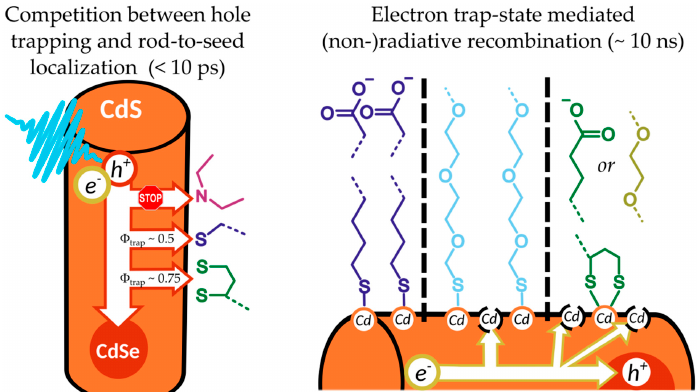
Figure 5. Summary of the effect of different water-soluble ligands on the excited state properties of CdSe@CdS NR. On a sub-10-ps timescale, mono- and ditholates offer hole trapping sites, opening a channel for processes competing with exciton localization to the CdSe core, while PEI prevents any trapping. On a ns-timescale, radiative exciton recombination is impaired by non-radiative processes induced by electron trapping sites. These result from the presence of either the bulky hydrophilic chain (PEG) or the anchoring group (in particular, DHLA). PEI (not shown) allows for a near-unity charge recombination, saturating surface defects very efficiently without inducing additional hole trapping sites. Surface ligands can impede charge carrier localization to the CdSe core. Photoinduced rod-to- seed localization of charge carriers is a fast process in NR, occurring within several picoseconds, and efficient rod-to-seed localization has been found to be a key parameter determining catalytic efficiency in systems building on seeded NR [4]. From excitation wavelength dependent photoluminescence quantum yield measurements, we could infer that trapping of holes on the surface efficiently competes with hole localization in mono- and dithiolate-NR, with trapping efficiencies of circa 0.5 and 0.75, respectively. PEI-coating, on the other hand, passivates the surface and changes the electronic structure of the NR that hole-traps are not accessible anymore, giving access to a rod-to-seed localization efficiency of nearly unity. Comparison of the relative amplitudes of the hole-localization driven electron rod-to-seed localization in transient absorption measurements were in good agreement with this finding. Hole localization in the seed in metal tipped seeded NR was shown to improve excited state lifetime [77], which correlates with improved photon-to-hydrogen conversion efficiencies [4]. In line with this, thiolate-NR showed significantly lower catalytic efficiencies compared to, for instance, PEI-NR [19]. Disorder in the ligand shell can be the source of additional electron trap states. Generally, the MAAs investigated behaved nearly identical compared to their PEG-analogues in terms of photoluminescence quantum yield and charge localization efficiency. However, some distinct changes in the photoluminescence decay, which is an indicator for the radiative recombination of the core-localized exciton on the nanosecond timescale, were recorded. While MUA-NR exhibited a monoexponential decay, it changed to a biexponential emission decay for HS-PEG-NR. This finding was rationalized on the basis that bulky PEG-chains inhibit high surface coverage of the NR with